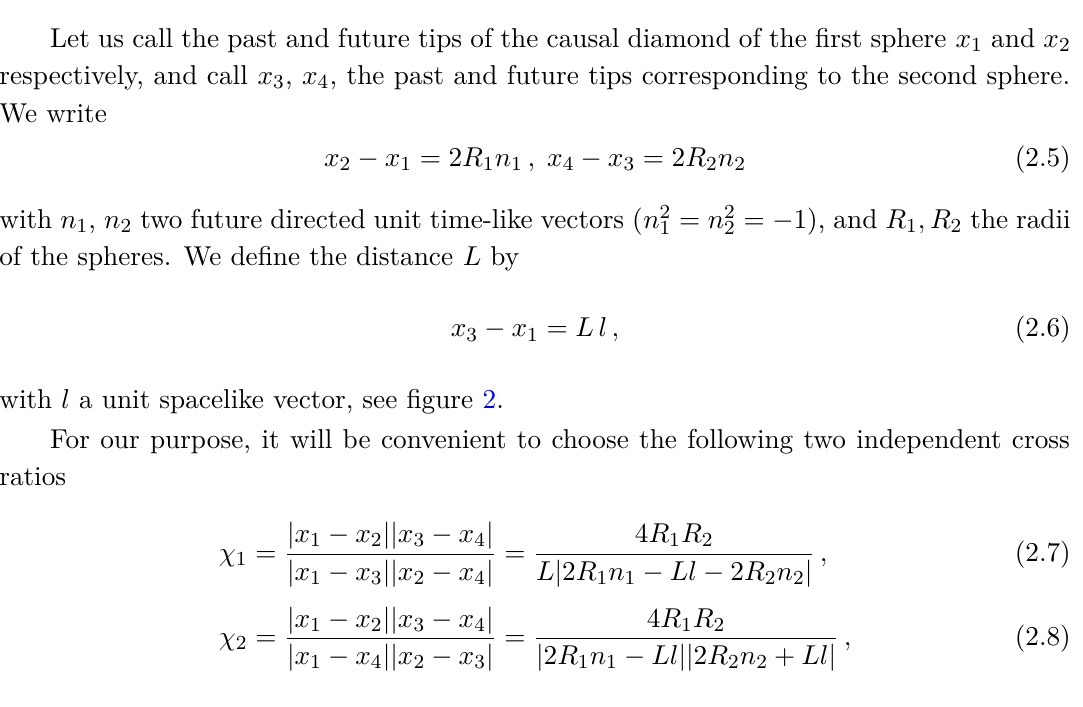
Figure 2 . Two spheres determined by four points x i located at the tips of their causal domains. In a CFT the mutual information between these two spheres is conformally invariant and depends solely on the two independent cross-ratios formed by x i in any